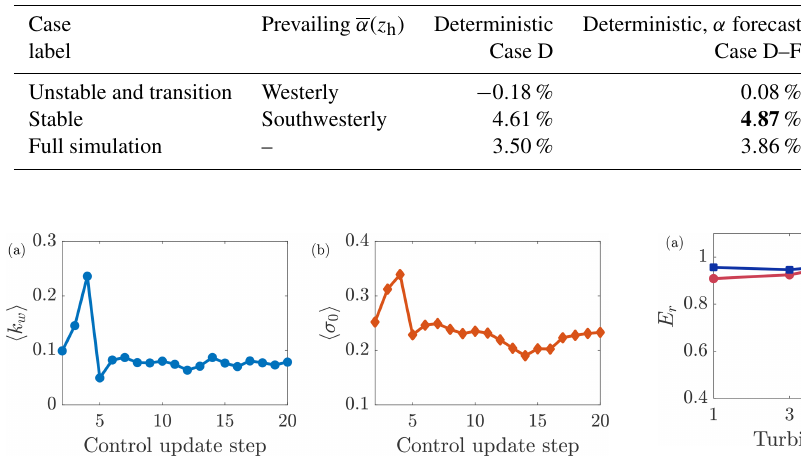
Figure 10. Diurnal cycle flow turbine-specific energy ratio E r ,i (Eq. 7) for (a) the odd and (b) even rows. The odd row consists of turbines 1, 3, 5, and 7. The even row consists of turbines 2, 4, 6, and 8. The turbine layout is provided in Fig. 1. Wake steering results from Case OUU-F are